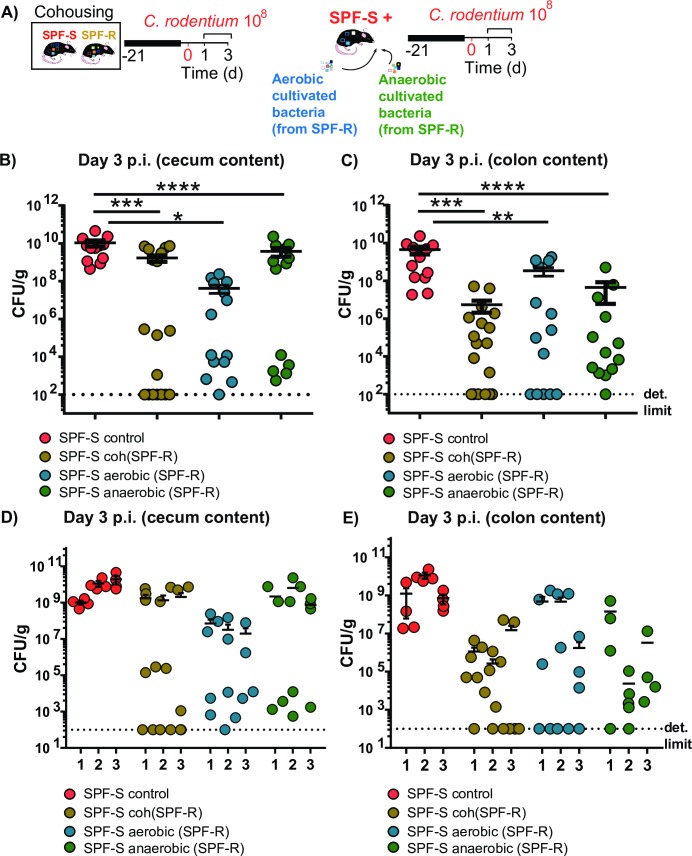
Cohousing and transfer of cultivable bacteria from resistant SPF-R mice leads to variable protective outcome in SPF-S mice.(A) Groups of susceptible SPF-S mice were pretreated with different bacteria. One group was cohoused with SPF-R mice for 3 weeks before infection. One group received a mixture of all cultivable aerobic bacteria isolated from cecal content of SPF-R mice. One group received all cultivable anaerobic bacteria isolated from cecal content of SPF-R mice. The last group was left untreated. All mice were infected with 108 CFU C. rodentium after 3 weeks and CFUs/g feces and organ content and tissue were assessed after day 1 and 3 p.i. (B-C) Pooled CFUs of C. rodentium in the cecal and colon content at day 3 p.i. are displayed. (D-E) CFUs of C. rodentium in the cecal and colon content at day 3 p.i. are for each single experiment are displayed. Results represent three independent experiments with n = 4–6 mice per group as mean with SEM. P values indicated represent a Mann-Whitney U test comparison between groups with *p<0.05, **p<0.01, ***p<0.001, ****p<0.0001.